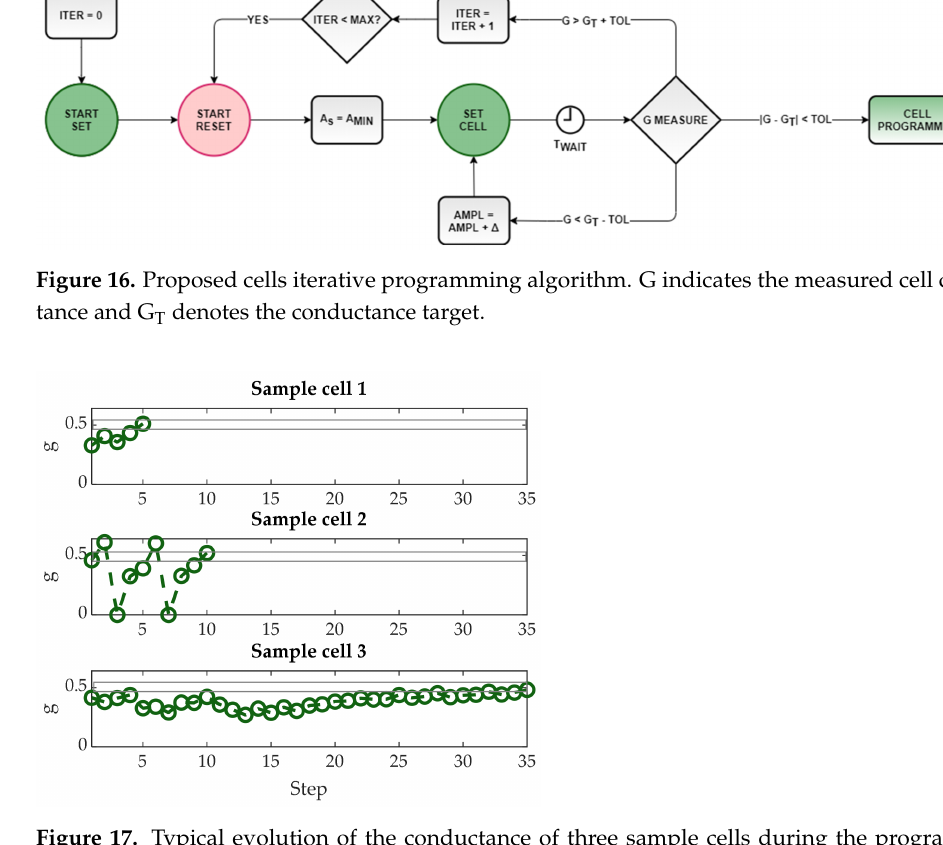
Figure 17. Typical evolution of the conductance of three sample cells during the programming sequence steps with the conductance target value set to 1/2 ± 10%. (1) Cell programmed in a few steps and only one iteration; (2) cell programmed in three iterations; (3) cell programmed with a long sequence of steps. The horizontal lines show conductance target ±